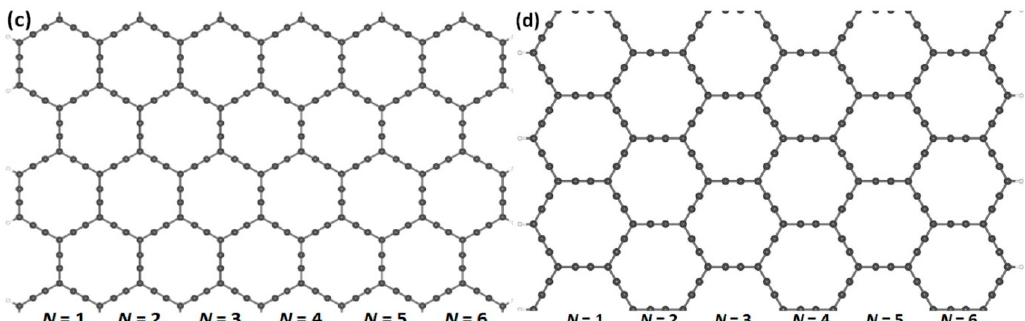
Figure 2. Armchair- and zigzag-edged nanoribbons can be obtained by cutting through an infinite graphyne sheet along two directions, horizontal and vertical. In ( a , c ), armchair-edged graphyne nanoribbons are shown with widths of N = 1 and 6, respectively, where N denotes the number of chains of carbon rings. In ( b , d ), zigzag-edged graphyne nanoribbons are shown with widths between N = 1 and 6. The gray and white spheres represent carbon and hydrogen atoms, respectively.